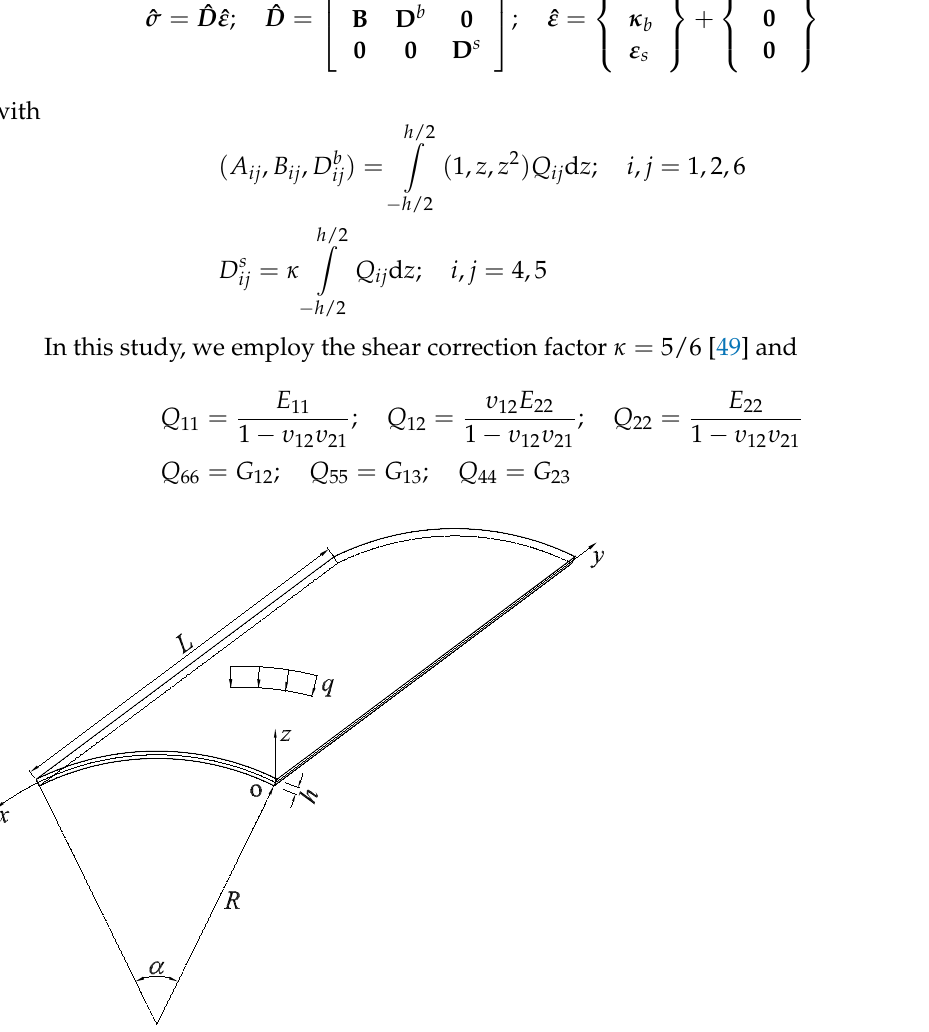
Figure 3. Initial geometry of a FG-CNTRC cylindrical